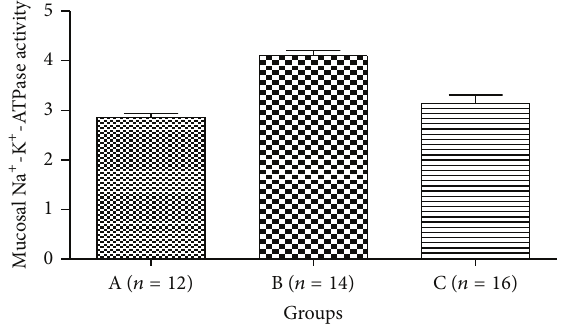
Figure 4: Graft mucosal Na + -K + -ATPase activity. In the pre-SNP group (B) Na + -K + -ATPase activity was significantly higher than that in the SBT group (A) ( 𝑃 < 0.05 ). There is no difference between post-SNP group (C) and the SBT group (A) ( 𝑃 > 0.05 ).